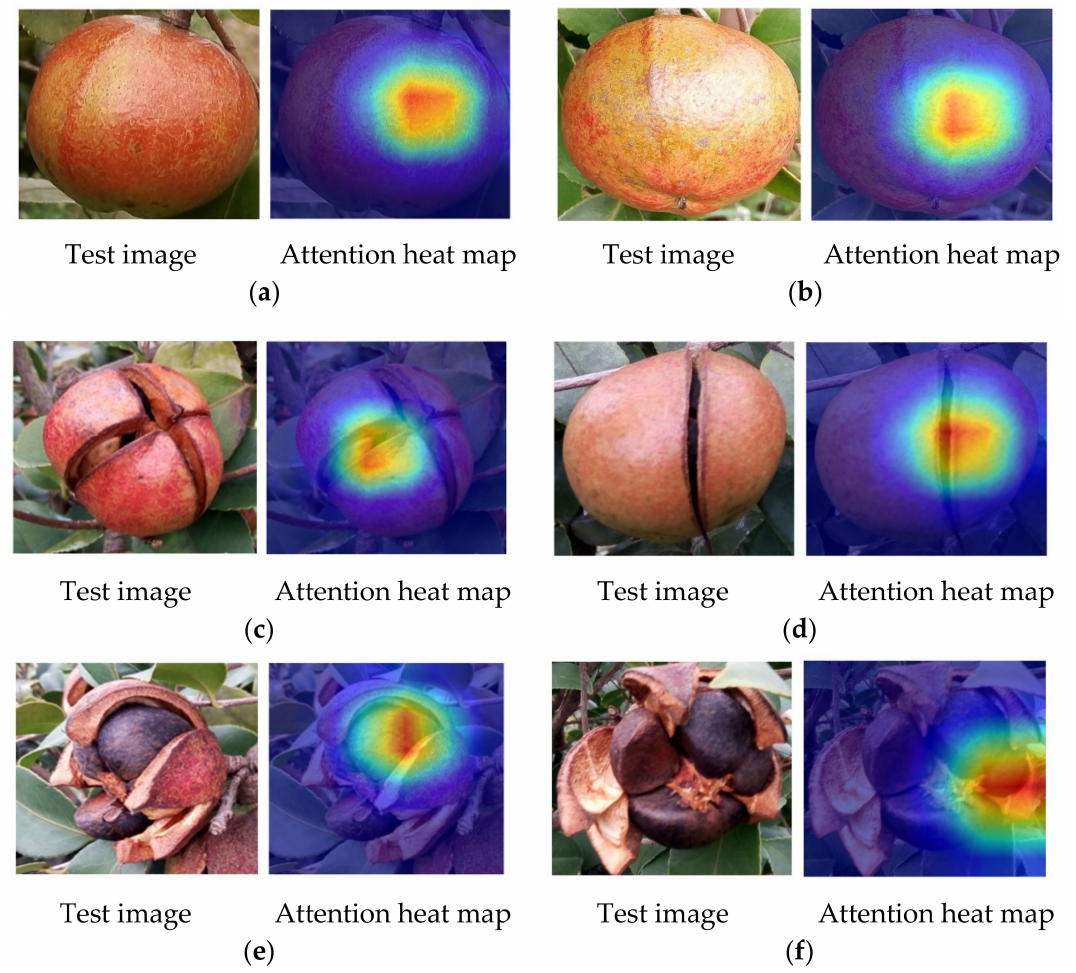
Figure 8. Heat maps of some Camellia oleifera fruit example images: ( a , b ) denotes example heat maps of unripe Camellia oleifera fruits, ( c , d ) denotes example heat maps of ripe Camellia oleifera fruits, ( e , f ) denotes example heat maps of overripe Camellia oleifera fruits. Here, warm colors indicate that the region has a strong contribution to the maturity